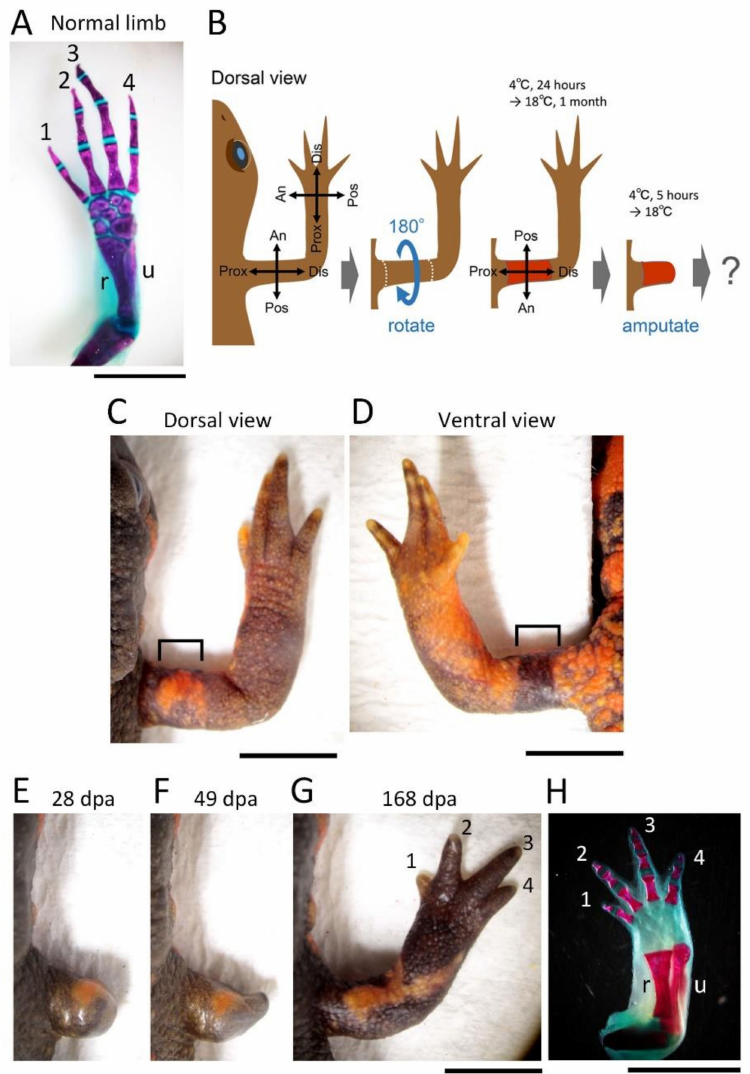
Figure 1. Normal regeneration of the limb with 180 ◦ rotated skin. ( A ) The skeleton of a normal forelimb. ( B ) Schematic showing the surgical process. ( C – H ) Representative showing normal regeneration of the operated limb (n = 17). ( C , D ) Dorsal and ventral views of the operated limb before amputation. Bracket: rotated skin. ( H ) The skeleton of the regenerated limb shown in ( G ). The skeleton in ( A , H ) as shown by Alizarin red (hard bone)-Alcian blue (cartilage) staining. Note that the cartilage of the regenerating limb is not always stained blue as shown in ( H ) (almost transparent). The number near the digit indicates digit number. dpa: day post amputation; u: ulna; r: radius. Scale bars: 5